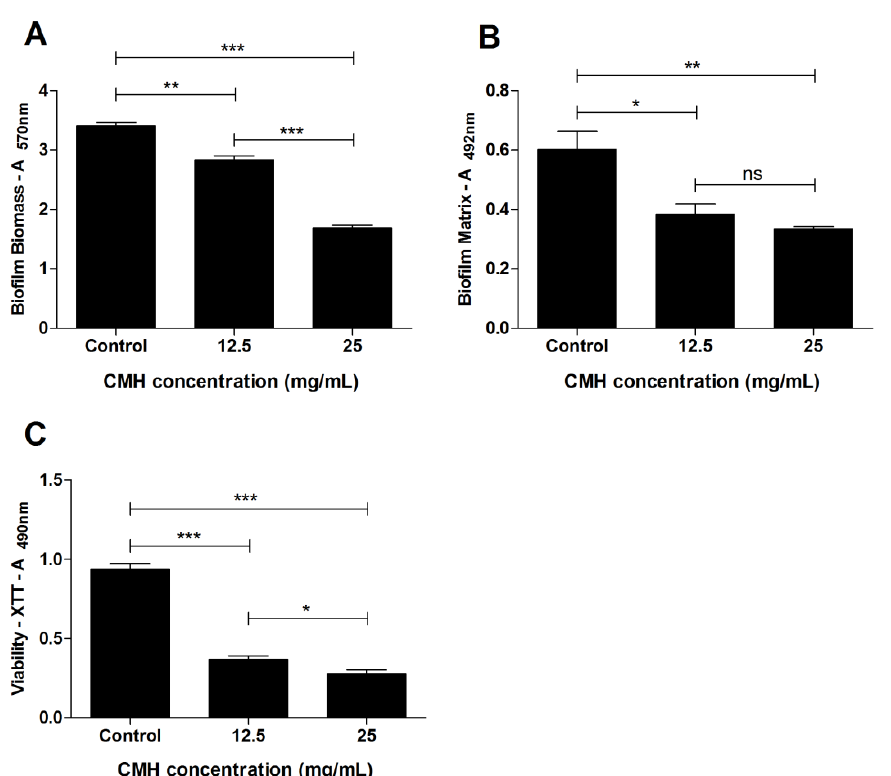
Figure 5. Effect of CMH on MRSA- S. aureus biofilm formation, after 24 h of growth. ( A ) Total biomass of the biofilm was quantified by crystal violet assay. ( B ) The biofilm matrix was quantified by safranin assay. ( C ) Metabolic activity of the cells inside the biofilm was detected by XTT-reduction assay. Statistical differences (* p < 0.05, ** p < 0.001, *** p < 0.0001) are represented by asterisks (ns =